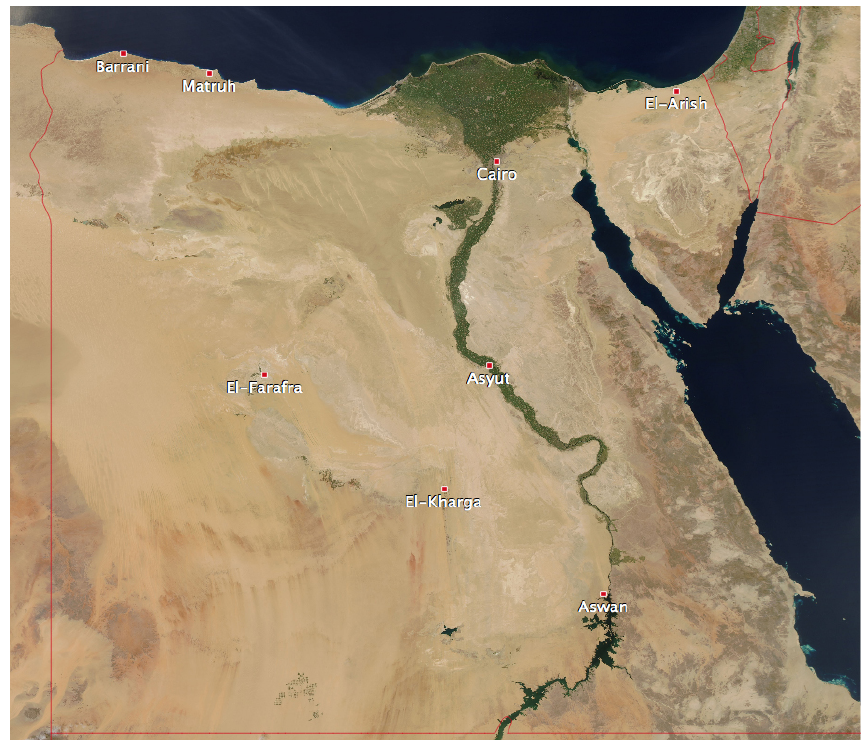
Figure 1. Location of the eight surface stations of the Egyptian Meteorological Authority (EMA) whose data are included in the SUSIE database. Table 1. Name, WMO#, Location (Lat–Long), altitude (m), SSI components measured ( B n : direct at normal incidence; D : diffuse; G : global), and type of climate for the eight